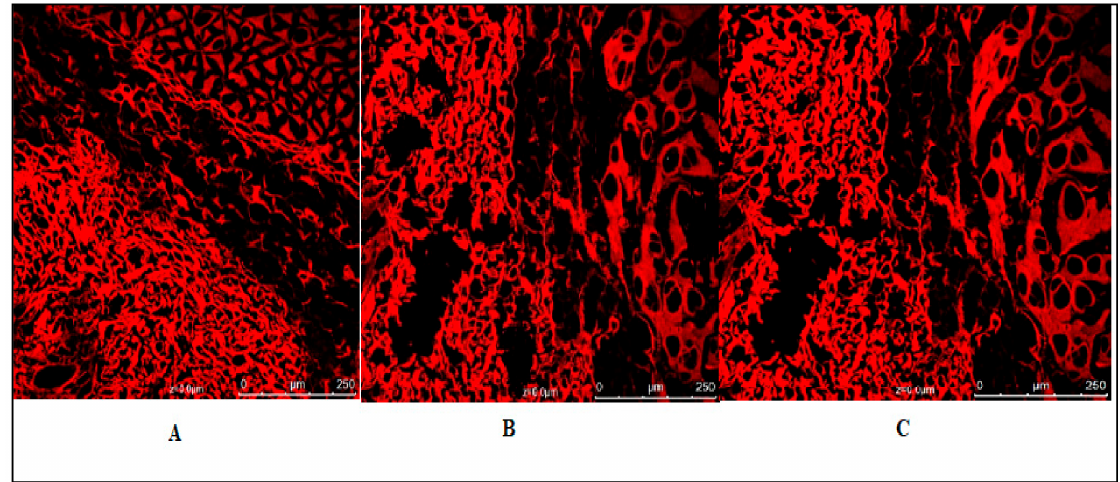
Figure 7. ( A ) CLSM photomicrographs of cross-sections of hairless viable rat skin, sectioned 0.5 mm (as standard for comparison) ( B ) Skin treated with HG ( C ) Skin treated with TH marketed gel